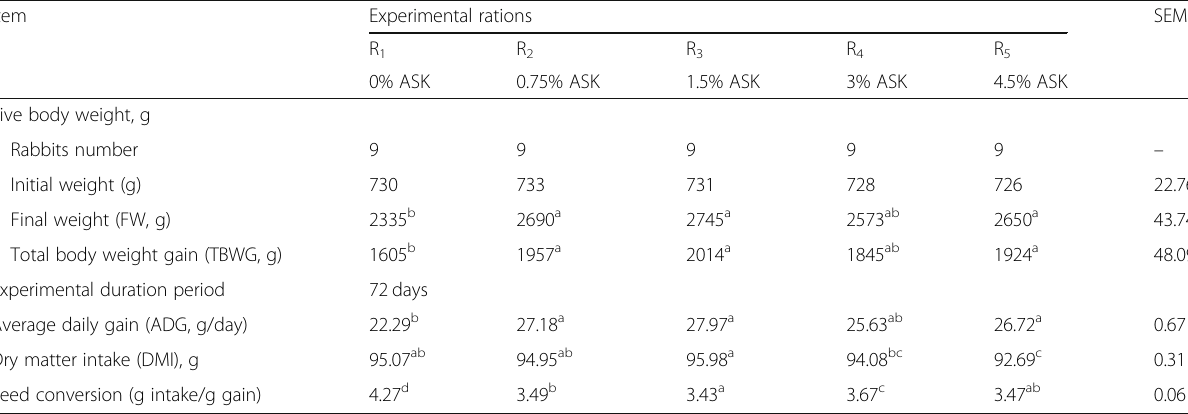
Table 3 Growth performance of the experimental groups Item